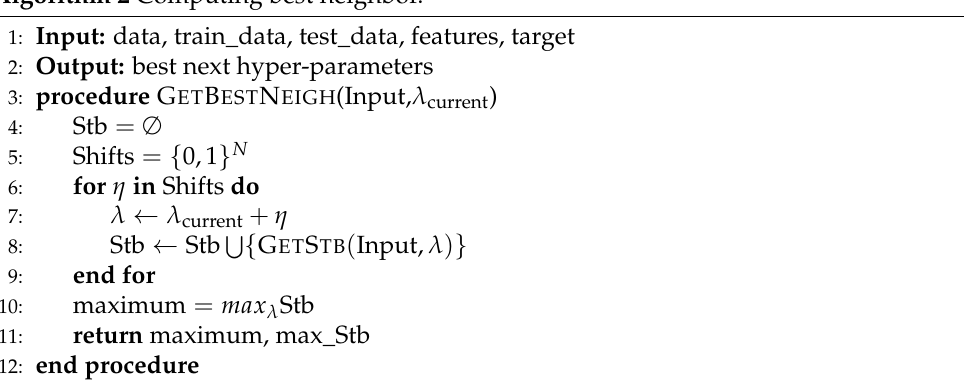
Algorithm 2 Computing best